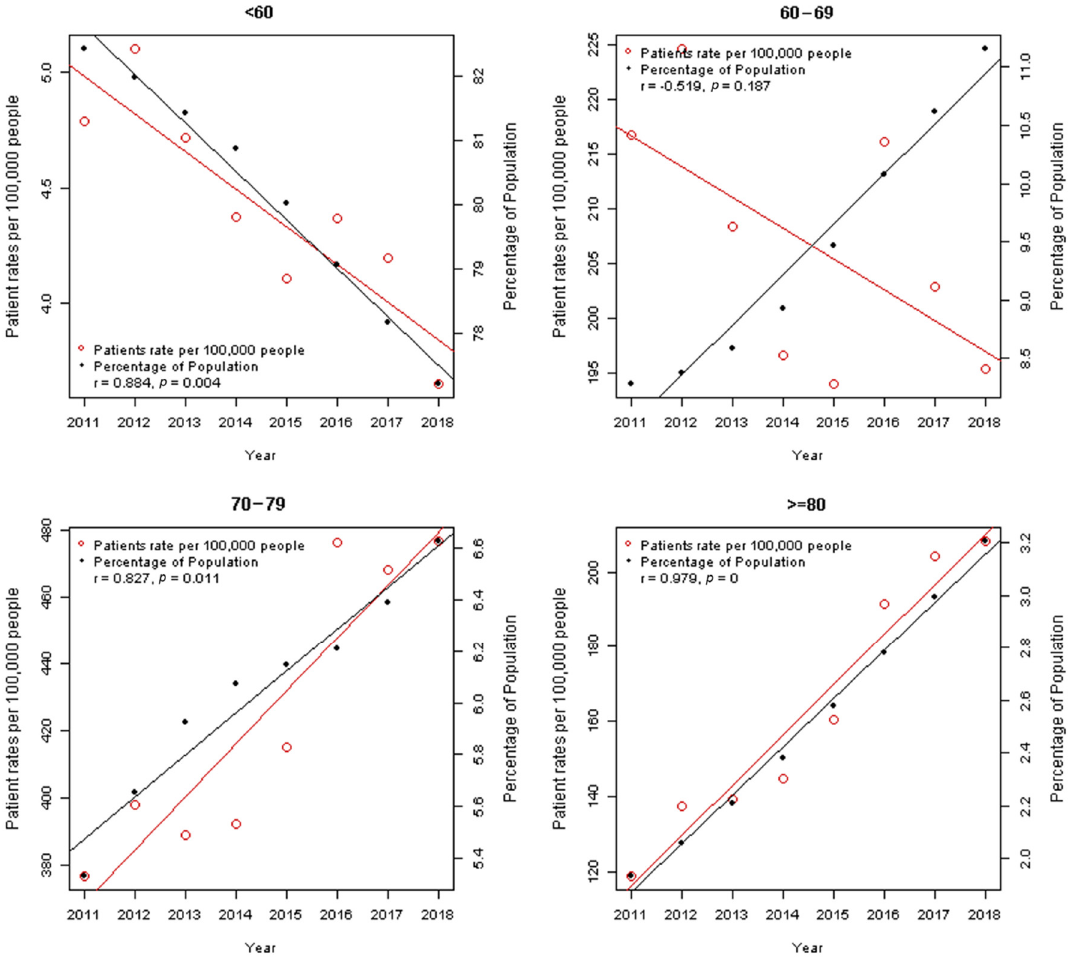
Figure 2. The association between the proportion of patients per 100,000 people and the proportion of population by year for every age group.